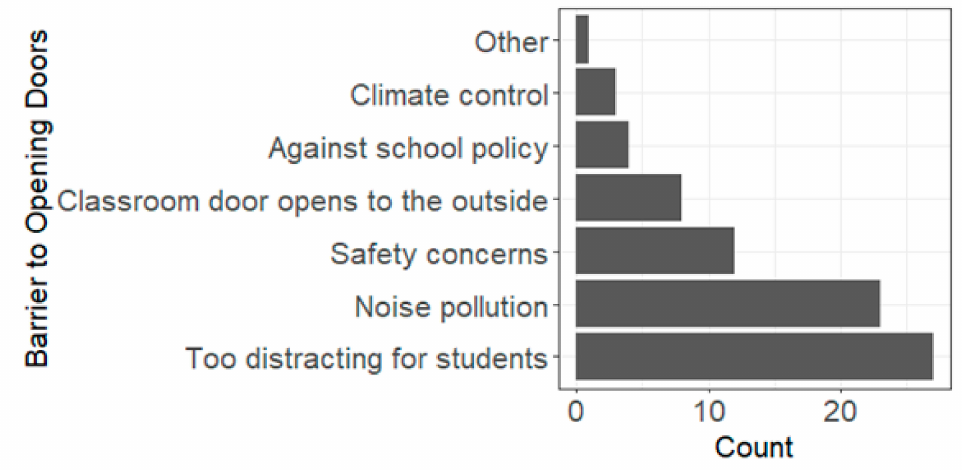
Figure 2. Barriers to opening windows during class time. Total count can be greater than the total number of participants, as participants could select more than one barrier to opening doors or windows.